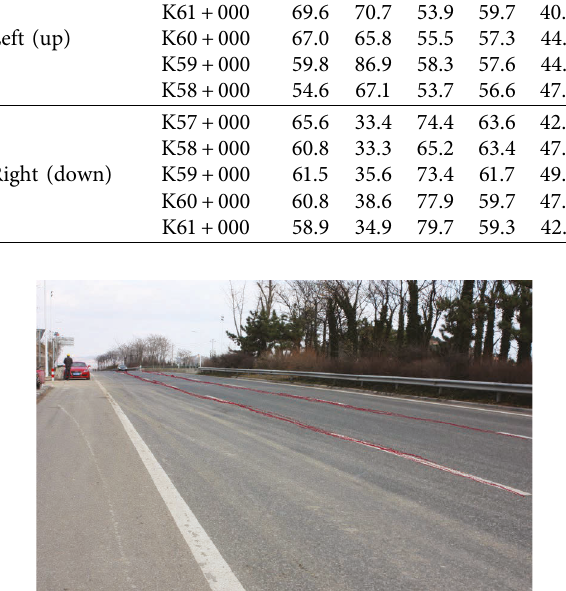
Figure 6: The Yangkou tunnel after rehabilitation.